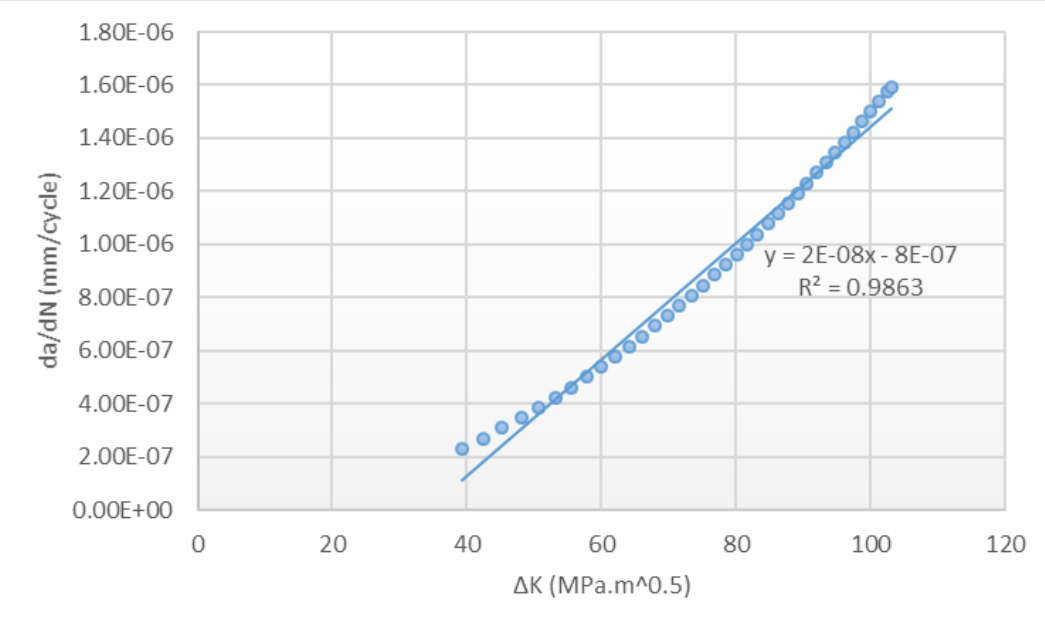
Figure A15. Stress intensity factor (∆K) vs. striation spacing. Bioengineering 2019 , 6 , x FOR PEER REVIEW